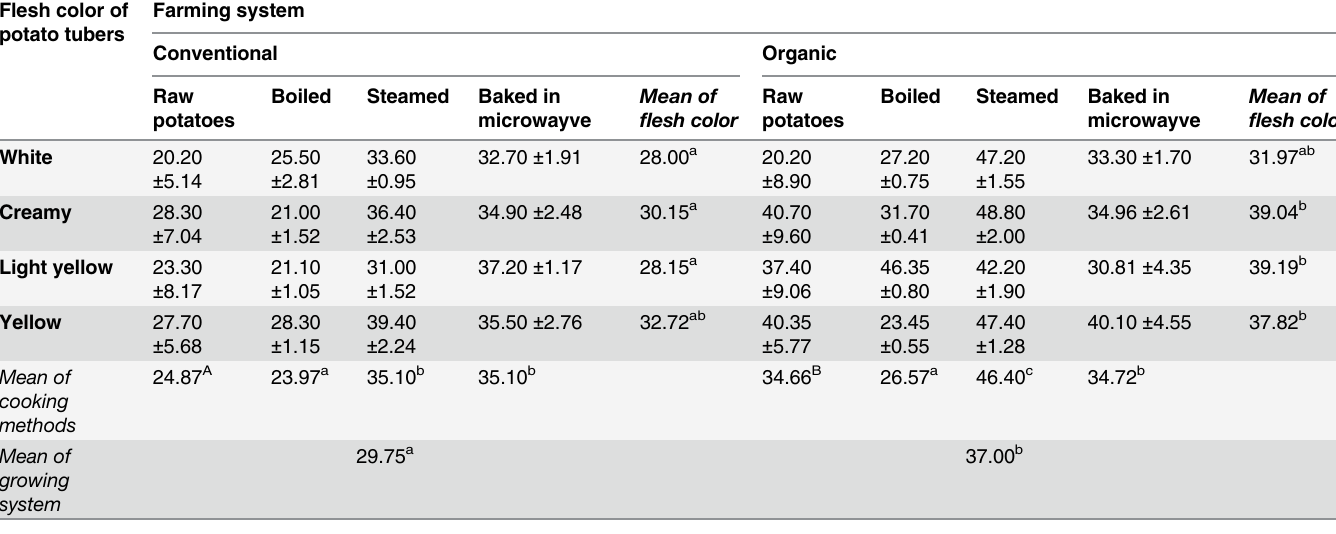
± , standard error of the mean Mean values denoted by the letters (a, b, c and A,B,C) are statistically signi fi cant P (cid:4) 0,05.